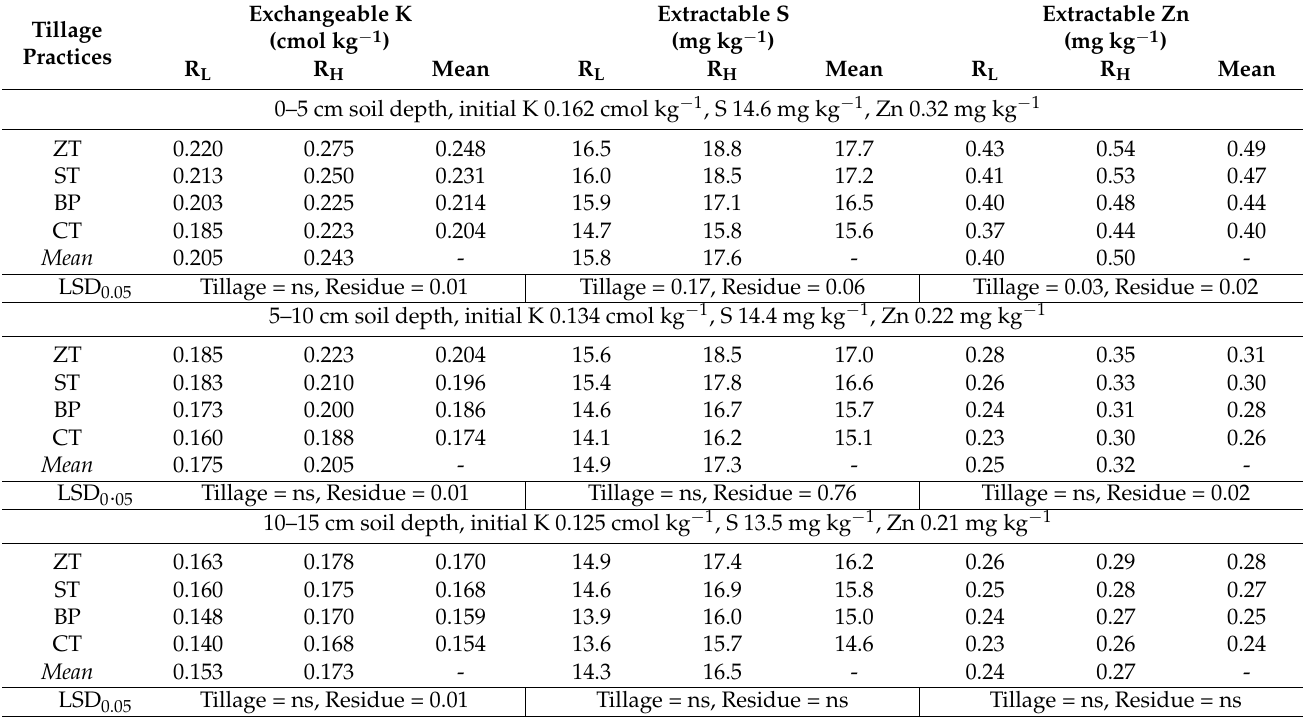
Table 5. Effects of tillage practices and residue retention levels on potassium, sulphur and zinc concentrations in soils after 3 years. Tillage Practices